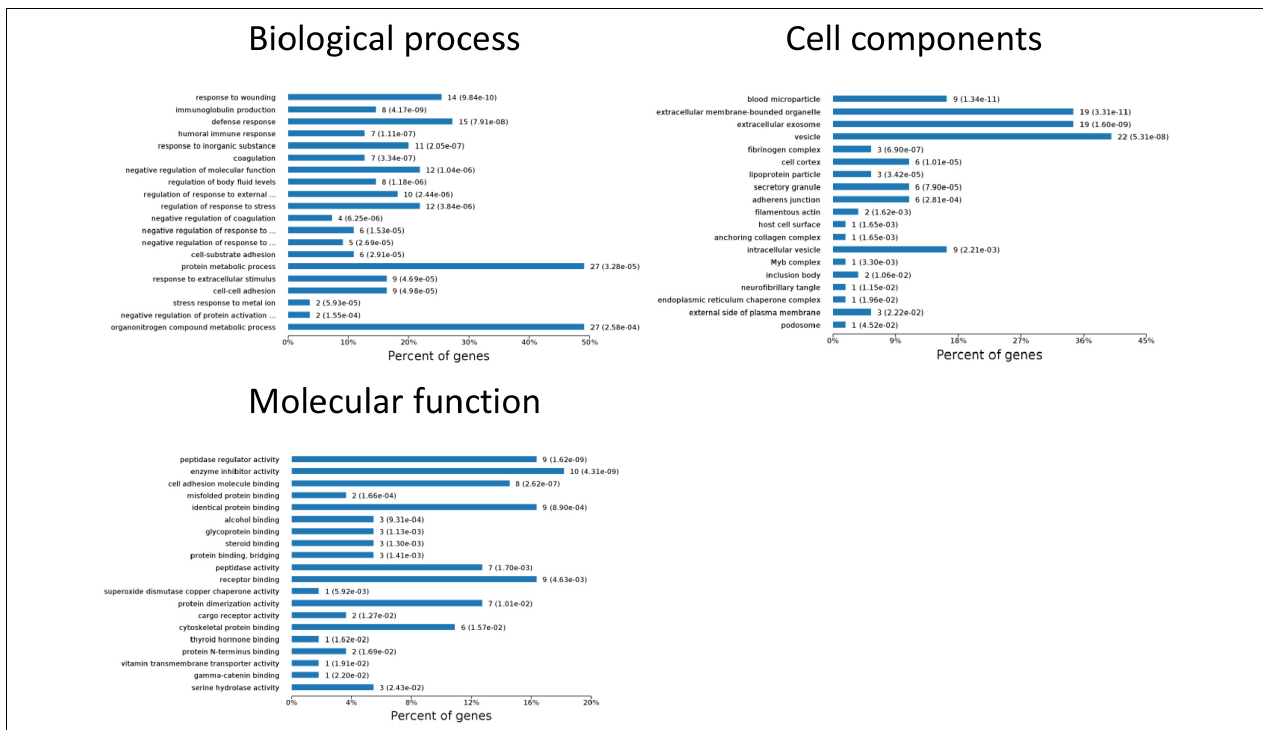
FIGURE 7 | Biological processes, cell components, and molecular functions in which continuously differentially expressed proteins are involved. P <